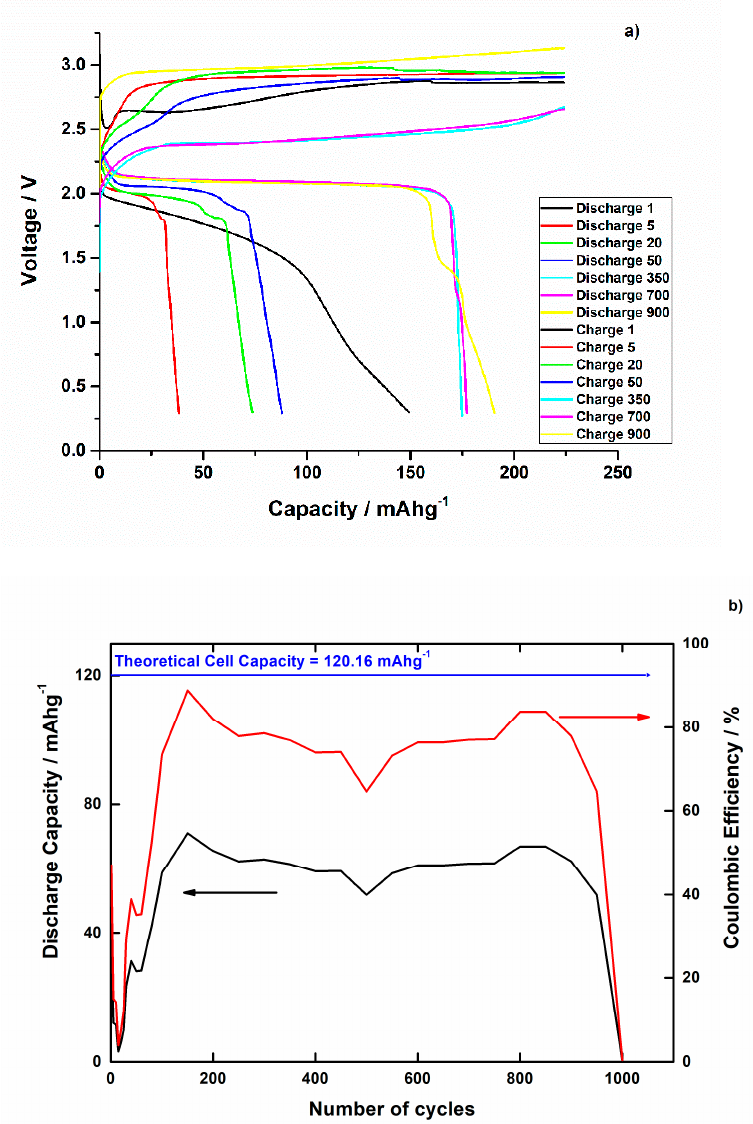
Figure 5. Electrochemical performance of a nanostructured lead-acid battery operating at 25 ± 2 ◦ C and 10 C: ( a ) charging and discharging curves of different cycles, and ( b ) cycling efficiency on discharging and discharge